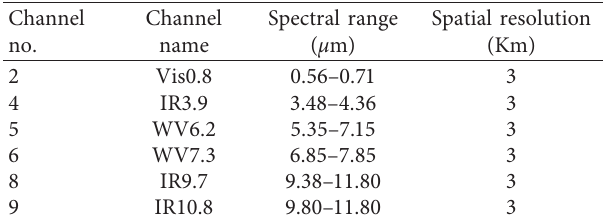
Table 2: Specifications of SEVIRI channels: spectral range and spatial